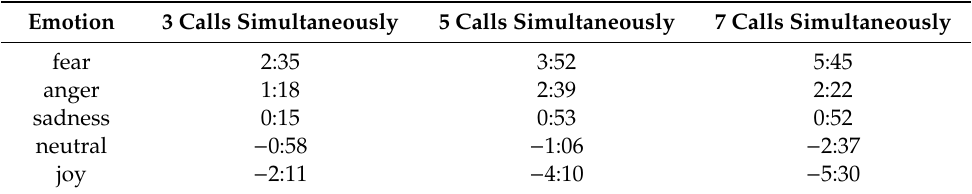
Table 5. Waiting time reduction after the proposed call redistribution is applied. Time is expressed in